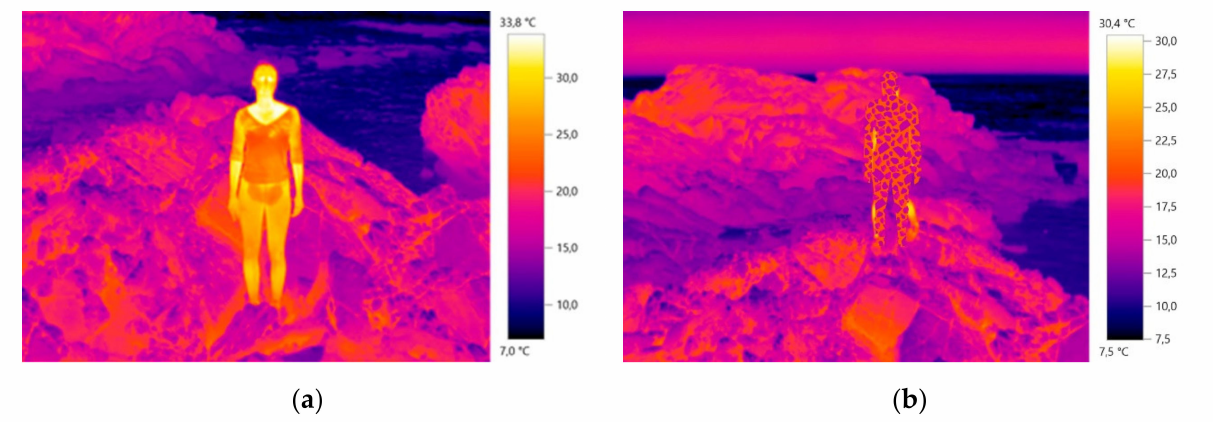
Figure 12. The nocturnal thermal camouflage prototype conceptualized: ( a ) Base thermal image without the Design elaboration for the camouflage; ( b ) Base thermal image with the prototype